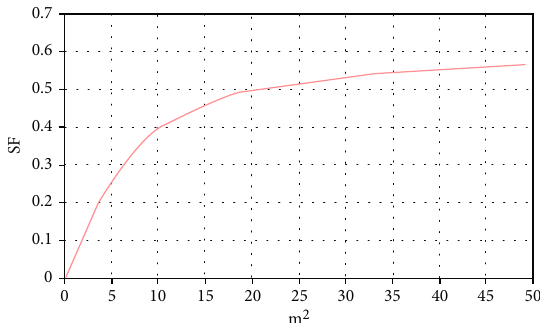
Figure 16: Solar fraction rate according to the area of the